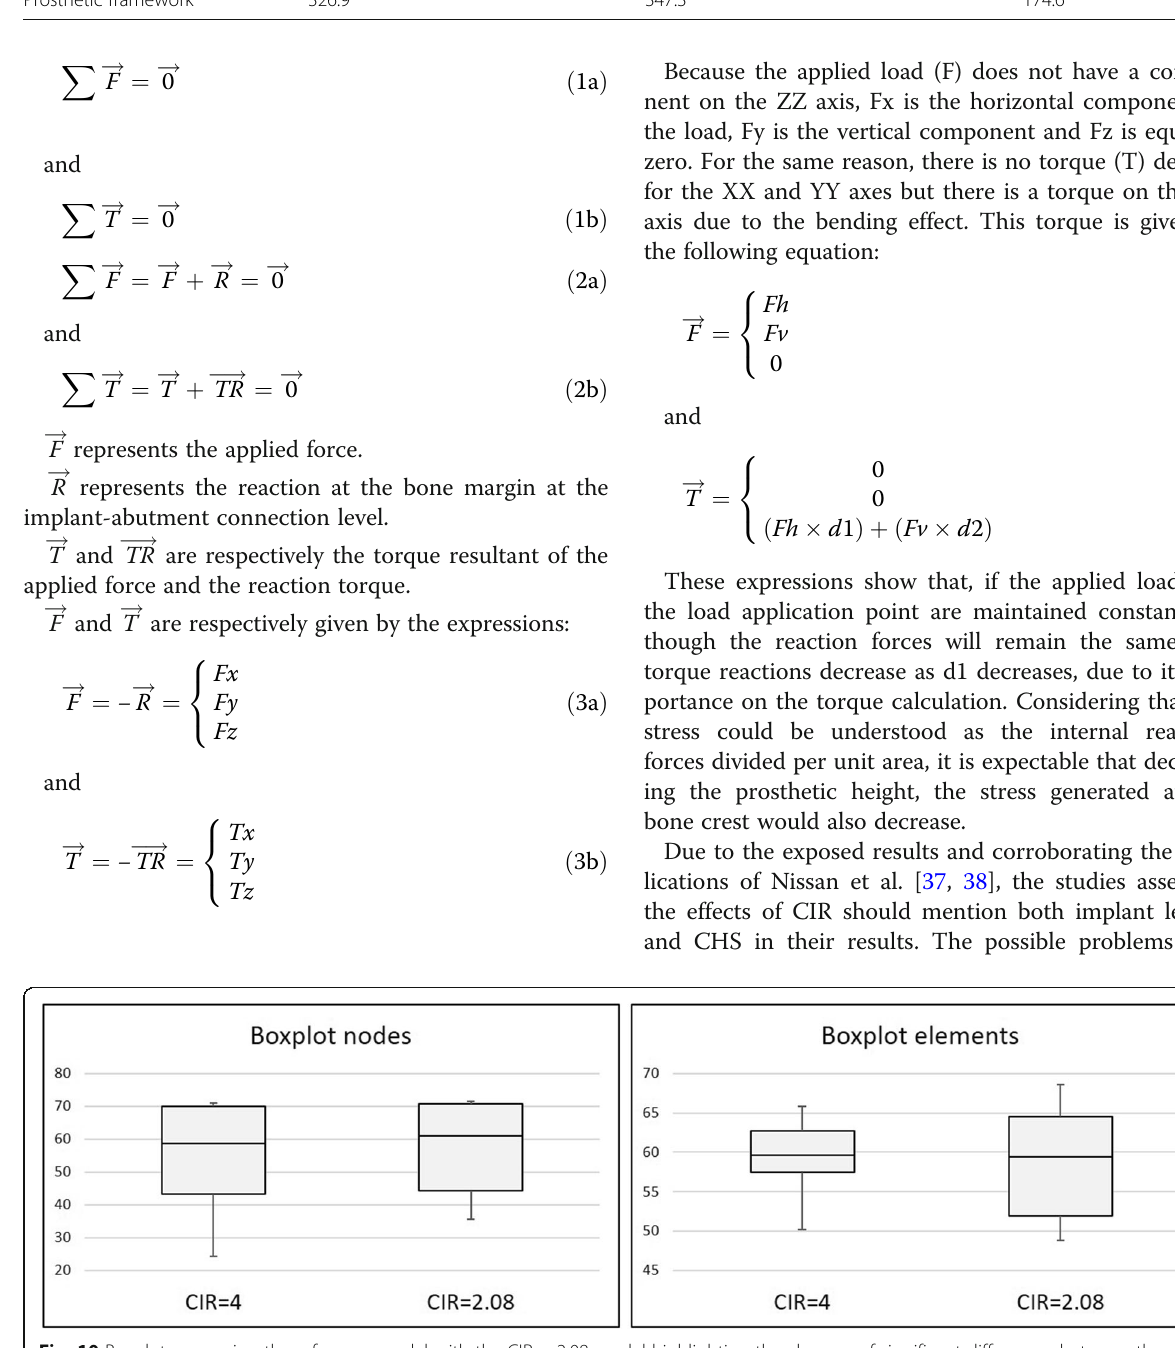
Fig. 10 Boxplot comparing the reference model with the CIR = 2.08 model highlighting the absence of significant differences between the stresses found in both